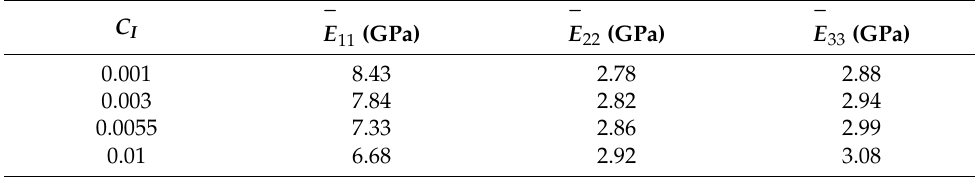
Table 2. Computed mean axial elastic constants of 13 wt.% CF/ABS deposited bead. C I